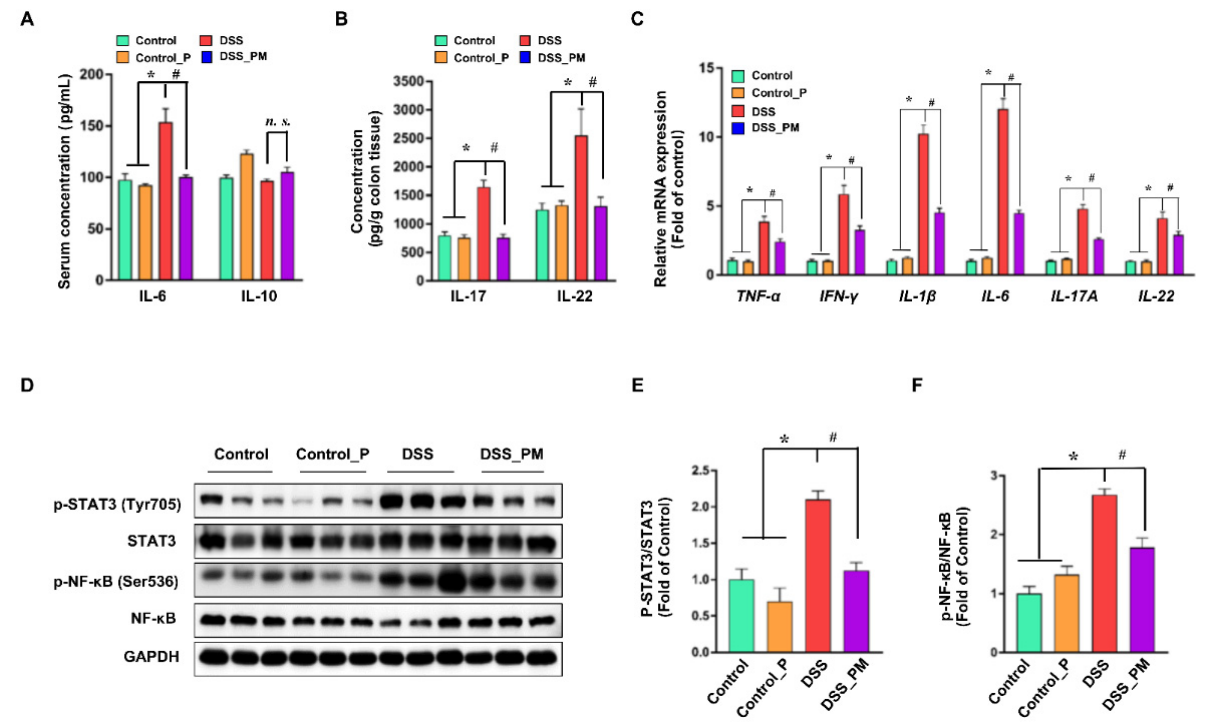
Figure 4. Pea albumin mitigated the induction of inflammatory response. ( A ) The serum protein level of IL-6 and IL-10. ( B ) The protein level of IL-17 and IL-22 in colon tissue. ( C ) Relative mRNA expression of TNF- α , IFN- γ , IL-1 β , IL-6, IL-17A, and IL-22 in colon tissue. ( D ) Representative bands of p-STAT3 (Tyr705), STAT3, p-NF- κ B (Ser536), NF- κ B, and GAPDH in colonic tissue. ( E , F ) Statisti- cal analysis of protein abundances in the colon. Data are shown as mean ± SEM. n = 9 per group. * p < 0.05 versus the control group. # p < 0.05 versus the DSS group. DSS, dextran sulfate sodium; Con- trol_P, 0.75 g/kg body weight pea albumin by oral gavage; DSS_PM, 2.0% w / v DSS in drinking water + 0.75 g/kg body weight pea albumin by oral gavage; NF- κ B, nuclear factor- κ B; STAT3, signal trans- ducer and activator of transcription 3.